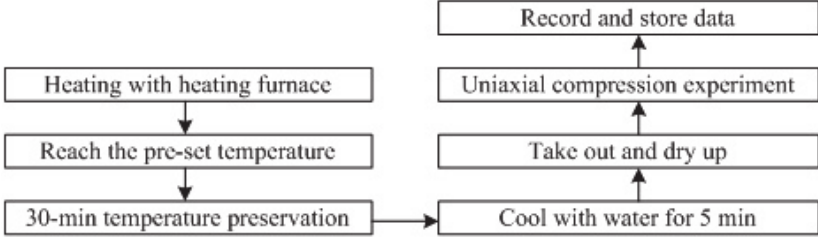
Figure 5: Experimental